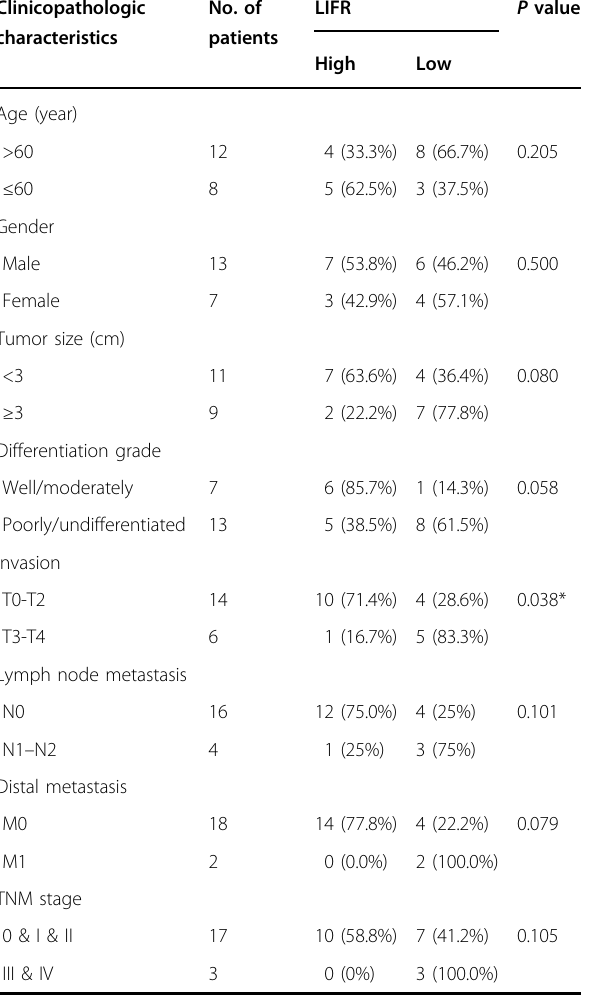
Table 2 The correlation analysis between hsa_circ_103820 expression and clinicopathologic characteristics in lung cancer. Clinicopathologic